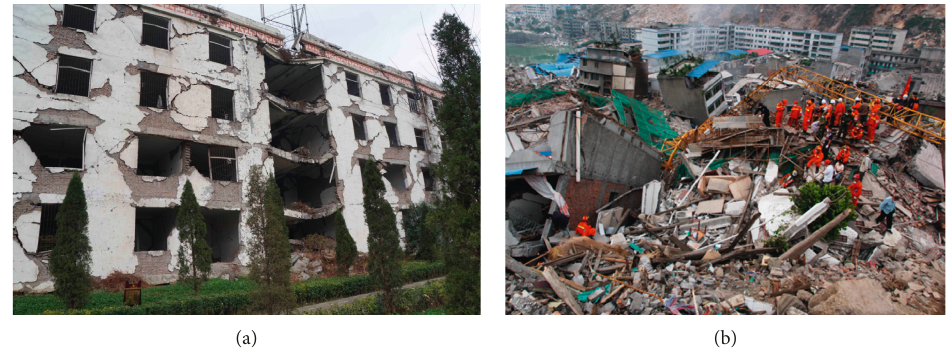
Figure 1: Common earthquake damage phenomenon of masonry housing: (a) inclined or “X”- shaped cracks; (b) collapse of the whole area of masonry housing.